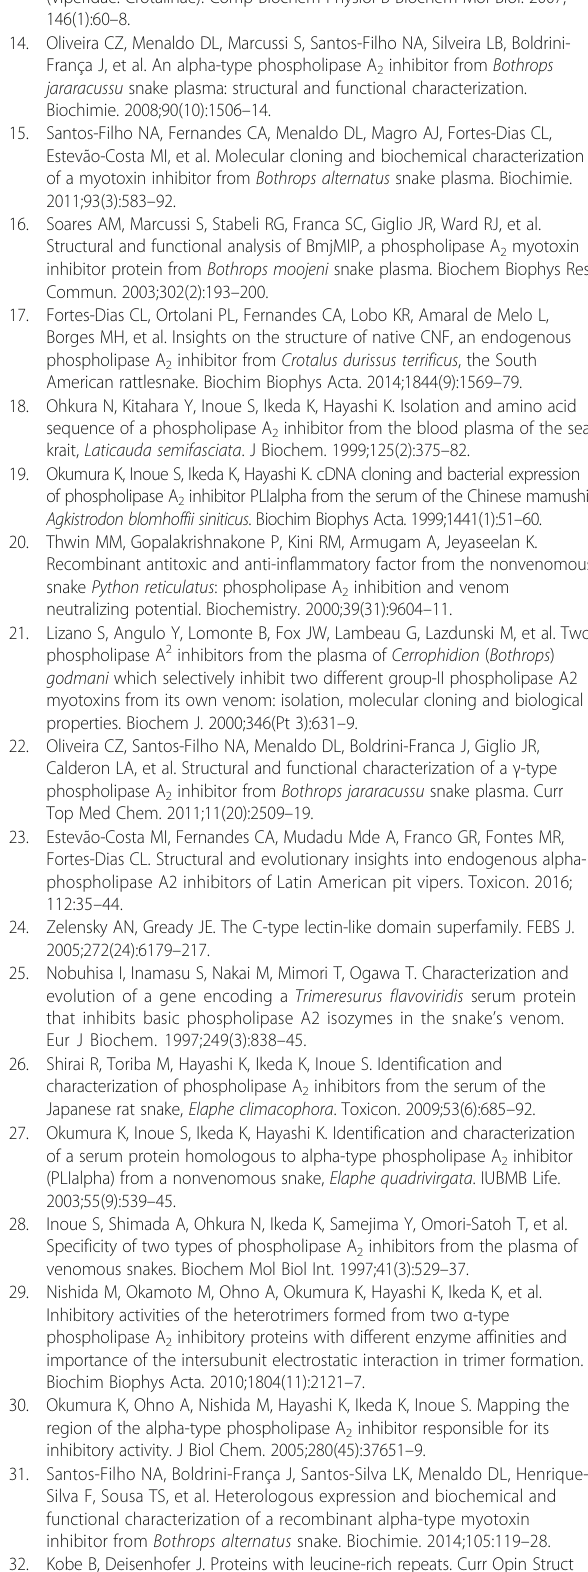
Abbreviations BaltMIP: Myotoxin inhibitor protein from Bothrops alternatus ; CA: Crotoxin A; CB: Crotoxin B; CICS: Crotoxin inhibitor from Crotalus serum; CNF: